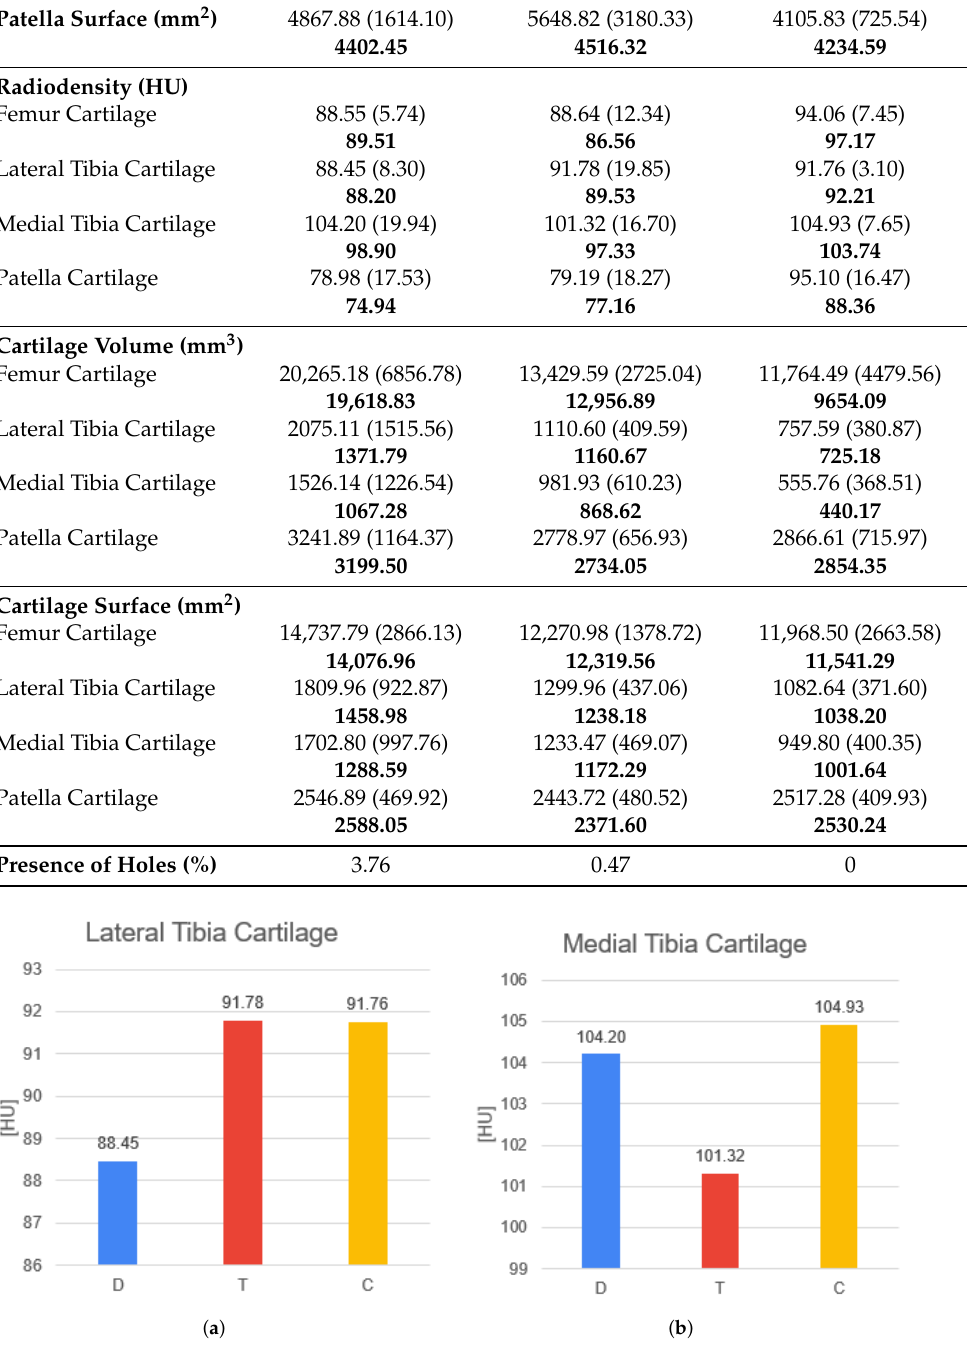
Figure 4. Comparison of the HU values for the two parts of tibia cartilage for D, T, C groups. ( a ) shows the average density value for the lateral tibia cartilage. ( b ) shows the average density value for the medial tibia cartilage. The results are the same as in Table